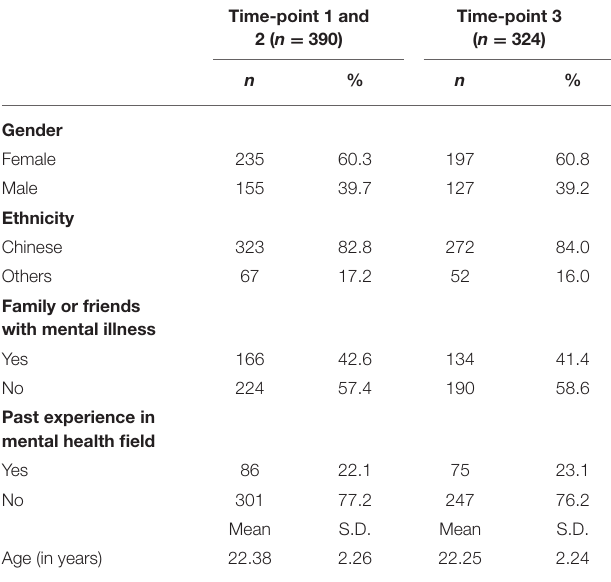
TABLE 1 | Sociodemographic characteristics of the